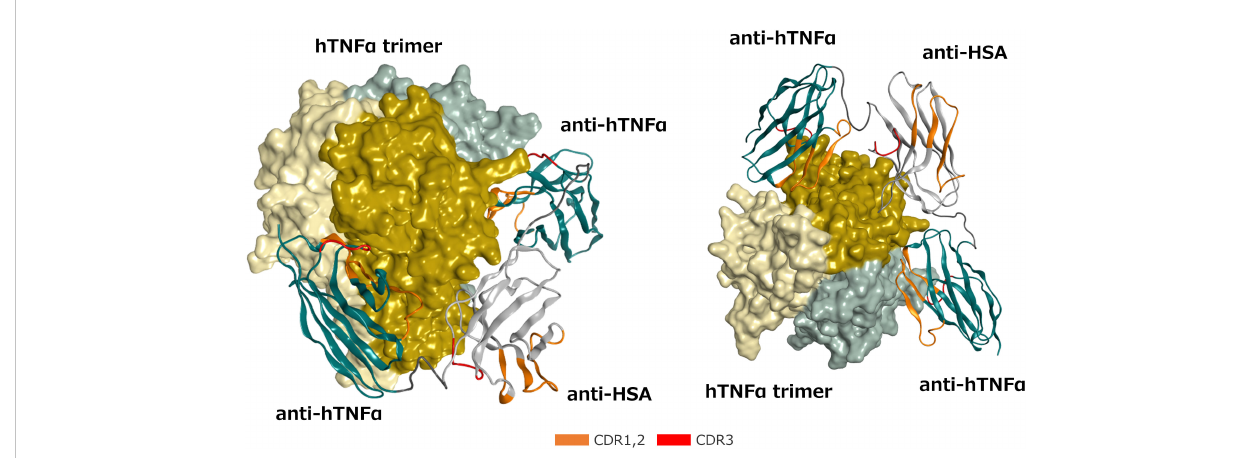
FIGURE 2 Front (Left) and bottom (Right) views of the predicted 3-dimensional structure of the ozoralizumab-TNF a trimer complex. The TNF a trimer molecule is shown with the molecular surface of each TNF a monomer unit colored dark yellow, light yellow, and light gray, respectively. The framework of the anti- TNF a NANOBODY ® and the framework of the anti-HSA NANOBODY ® are colored green and white, respectively. The CDRs are de fi ned according to the Kabat numbering scheme and colored orange (CDR 1 and 2) and red (CDR3), respectively, and the two linkers are colored dark